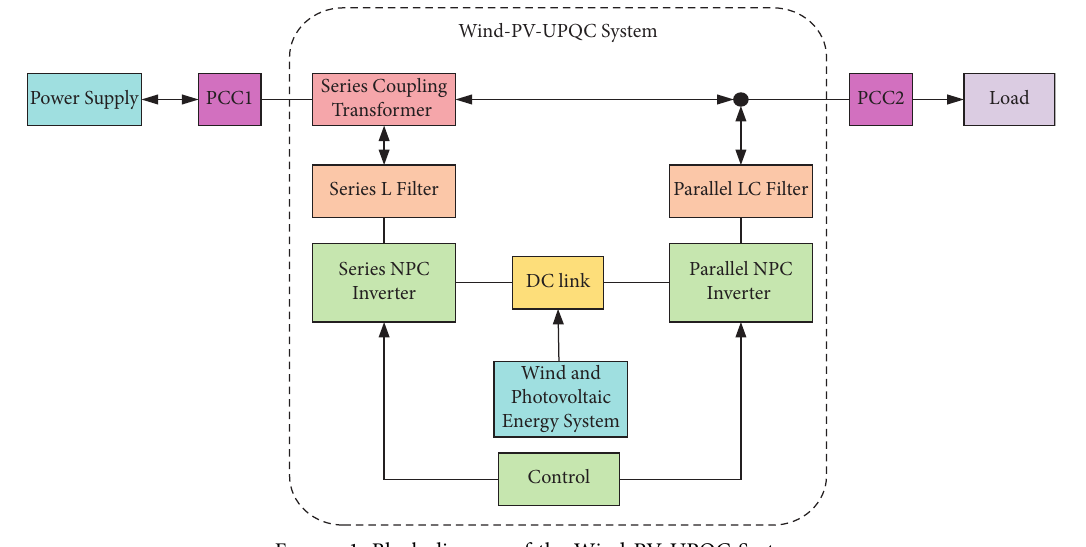
Figure 1: Block diagram of the Wind-PV-UPQC